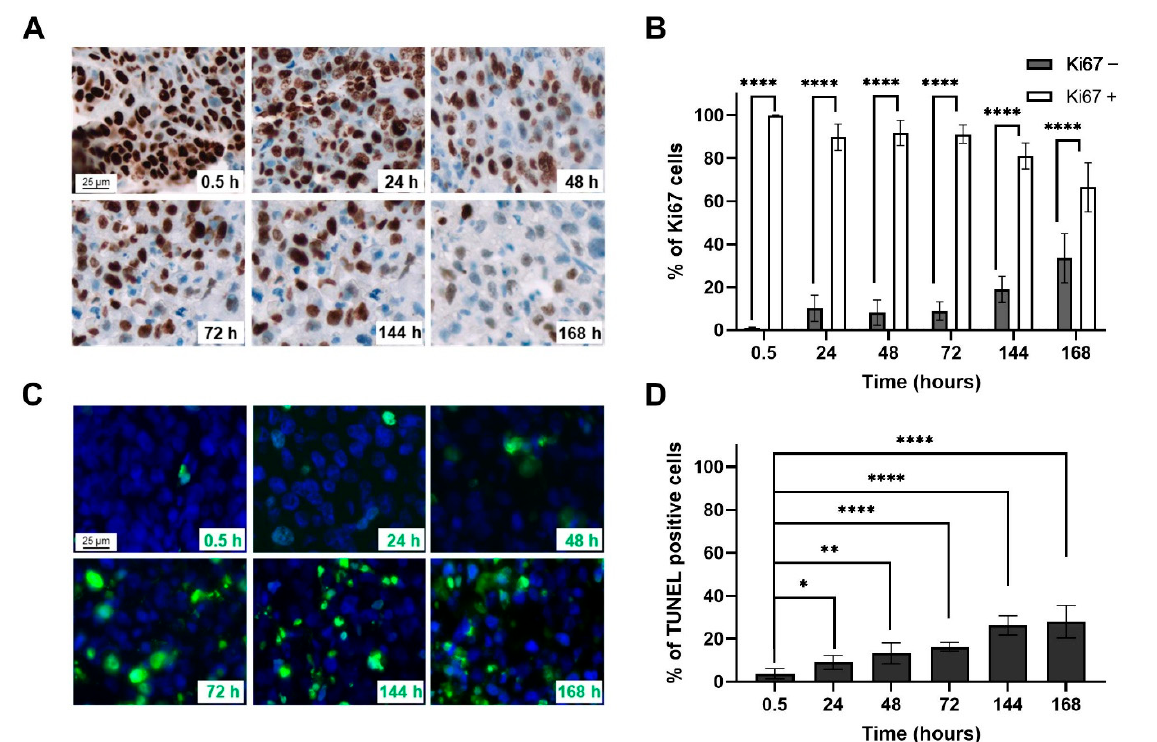
Figure 1. ( A ) . Representative microscopic acquisitions (20×) showing tumour cell proliferation assessed by Ki67 staining in tumour slices after different culture times. ( B ) Average percentage ± Standard Deviation (SD) of Ki67 tumour nuclei following categories based on the nuclear intensity: grade − (none and weak brown staining); grade + (moderate and strong brown staining). ( C ) Representative microscopic acquisitions (20×) showing apoptotic tumour cells assessed by TUNEL staining in tumour slices after different culture times. ( D ) Average percentage ± SD of apoptotic tumour cell nuclei. A minimum of 200 fields per slide were analysed per condition. Student’s t -test was used for statistical analyses (* p < 0.05, ** p < 0.01, **** p < 0.0001).